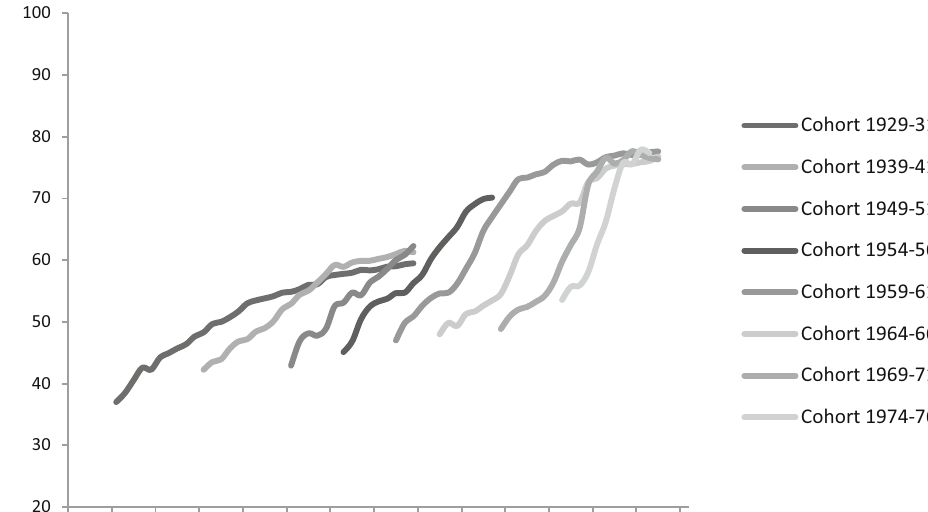
Fig. 2 Development of career profiles (average MPS) of suc- cessive cohorts of West German men (1945–2008). (Sources: GLHS and ALWA – own calcu-